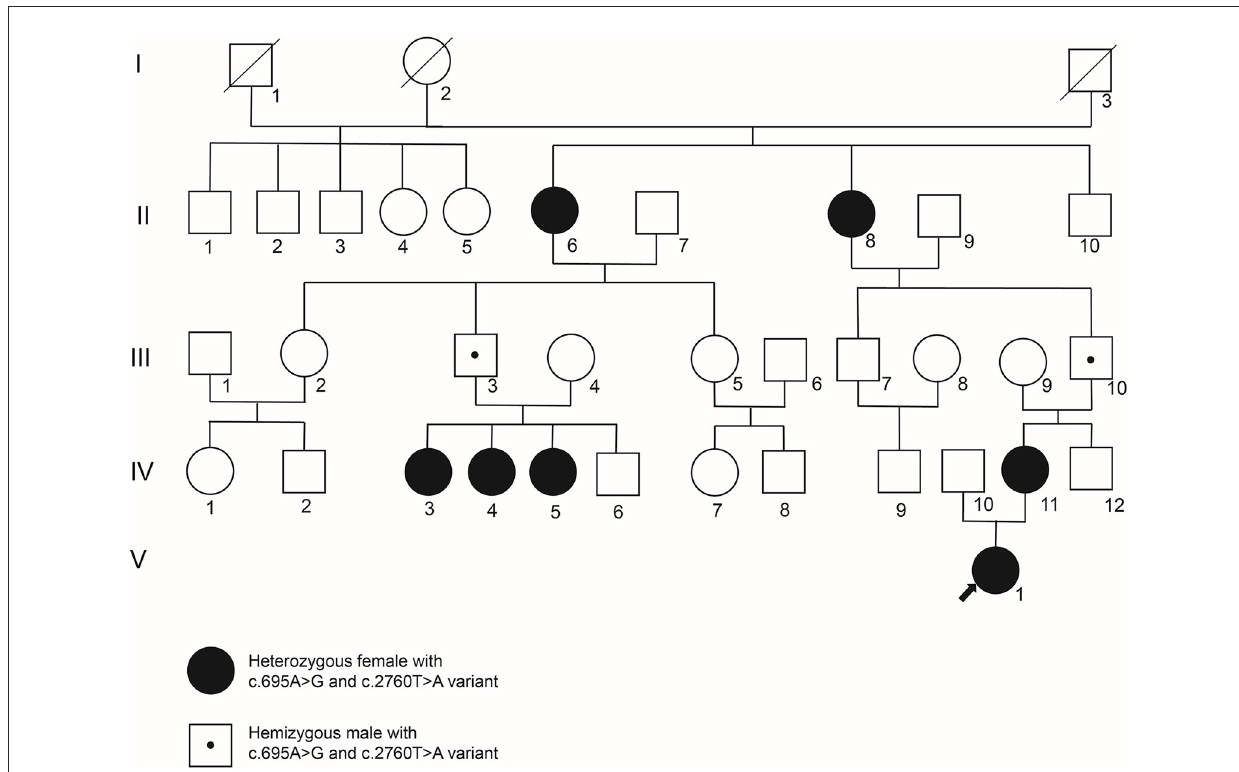
FIGURE1 The genogram of a five-generation PCDH19 -FE pedigree. While filled circles represent female patients, empty squares or circles represent unaffected males or females, respectively. The empty square or circle with an oblique line denotes a deceased male or female. And an empty square with a small point symbolizes an unaffected male who is a carrier of PCDH19 c.695A > G and c.2760T > A variants. Blood samples of II:6, II:8, III:3, III:4, III:9, III:10, IV:3, IV:4, IV:5, IV:6, IV:11, IV:12, and V:1 were collected for genetic variant